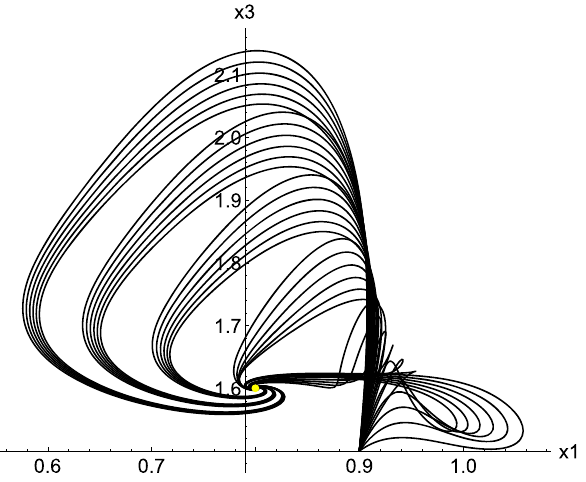
Fig. 7 The evolution towards the B critical point in the x 1 Ox 3 plane in the case where n = 0 . 5, m = 0 . 8. The initial conditions have been fine-tuned. The B critical point appears as a yellow dot